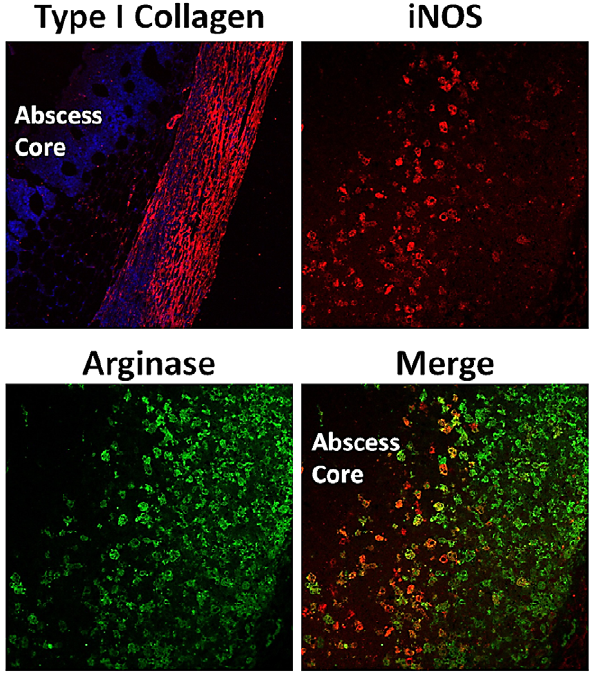
Figure 9. Mouse subcutaneous abscess model. C57BL/6 flank abscesses caused by subcutaneous injection of 5 6 10 5 CFU of S. aureus JE2. Tissues were processed for immunofluorescence staining for either type I collagen (red), inducible nitric oxide synthase (iNOS, red), or arginase (green). In addition to type I collagen, tissues were processed with the DAPI nuclear stain (blue) to accentuate the abscess core. Representative confocal microscopy images are presented for type I collagen (10 6 magnification) and iNOS/arginase (20 6